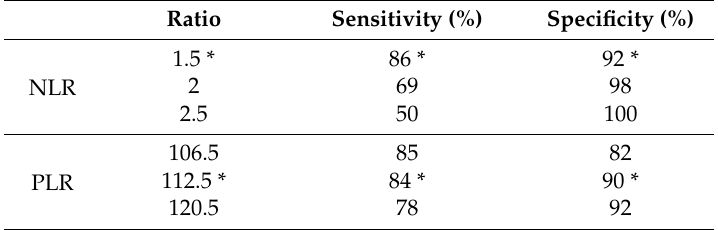
Table 4. The sensitivity and specificity of NLR and PLR in detecting lung cancer.